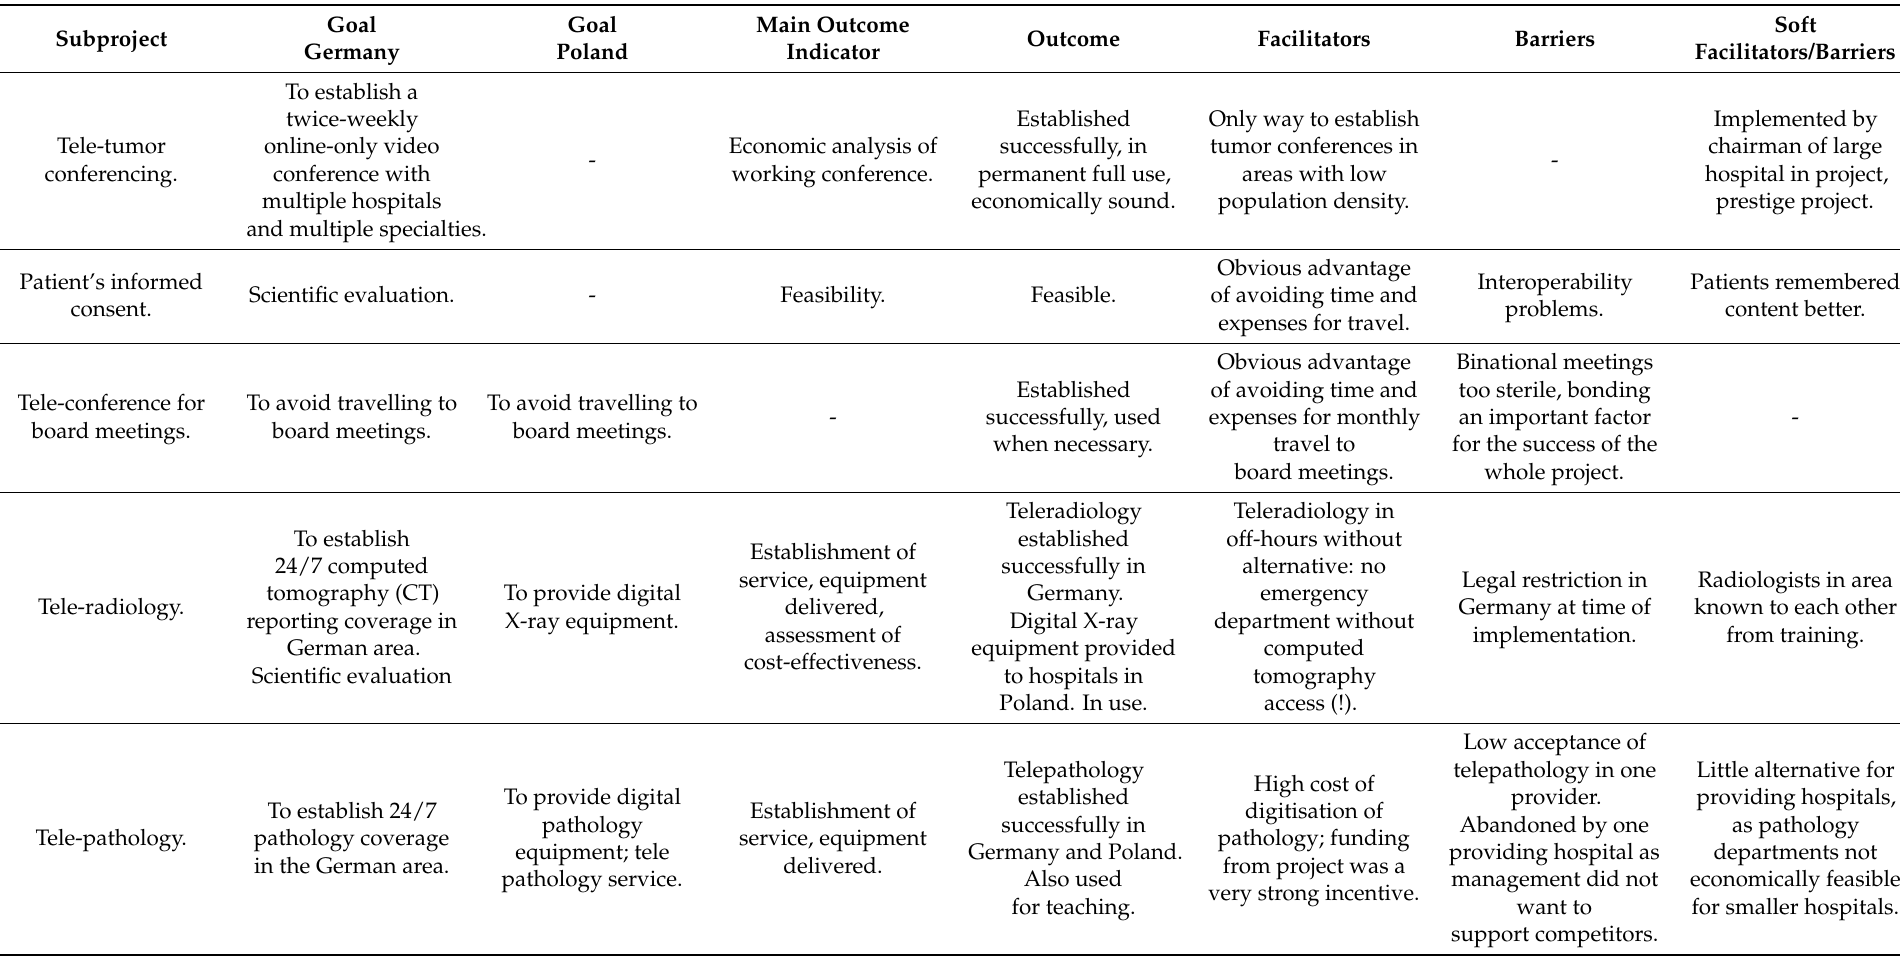
Table 1. Subprojects. Note, different goals for the German and Polish sides. Outcomes and outcome indicators are given and facilitators and barriers are listed. See details in text.